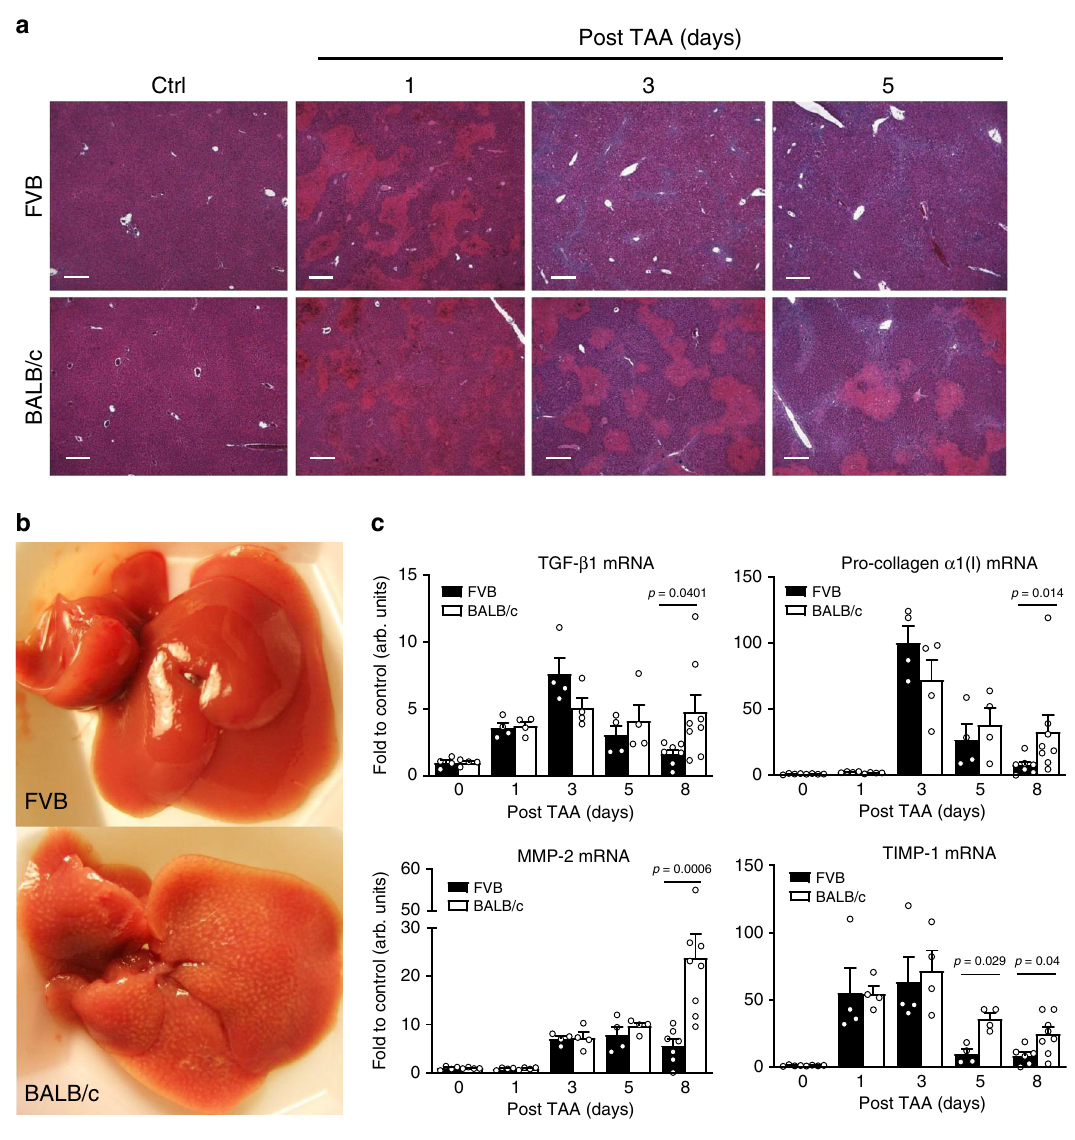
Fig. 2 Delayed clearance of dead hepatocytes after injury precedes ampli fi ed fi brotic response in fi brosis-susceptible BALB/c strain. a Histological examination suggests that single-dose TAA causes similar cell death in livers of FVB and BALB/c mice, but that the subsequent clearance rate of necrotic masses differs signi fi cantly. Necrotic masses (eosinophilic areas) are rapidly cleared in fi brosis-resistant FVB mice (by day 3), but persist in fi brosis- susceptible BALB/c mice past day 5 (representative low-magni fi cation images, hematoxylin/eosin, ×50; bar, 20 μ m). b Macroscopic appearance of representative livers from FVB and BALB/c mice 8 days post-TAA injury. FVB livers completely recovered by day 8 and appear virtually indistinguishable from healthy uninjured liver, while BALB/c livers demonstrate increased turgor, stiff consistence, and strong whitish pattern indicative of incomplete repair. c Pro- fi brogenic gene expression in post-TAA livers indicate that delayed normalization of multiple pro- fi brogenic mRNA expression is associated with fi brosis susceptibility in BALB/c mice. No signi fi cant strain difference at peak of fi brogenic response was observed (day 3). Hepatic expression of pro- fi brogenic (pro-collagen α 1(I), TGF β 1, TIMP-1, and MMP-2) transcript levels was quanti fi ed by QRT-PCR during recovery (0 – 8 days) after single TAA injury. Results are expressed as means ± SEM, fold to healthy wild-type controls relative to β 2MG mRNA (for each strain at 0/1/3/5/8 days time-points, n = 4/4/4/4/7 (FVB), n = 4/4/4/4/8 (BALB/c) of individual animals). P value as indicated (two-tailed, Mann – Whitney t test, not adjusted) when both strains are compared at corresponding time-point. Source data are provided as a Source Data fi